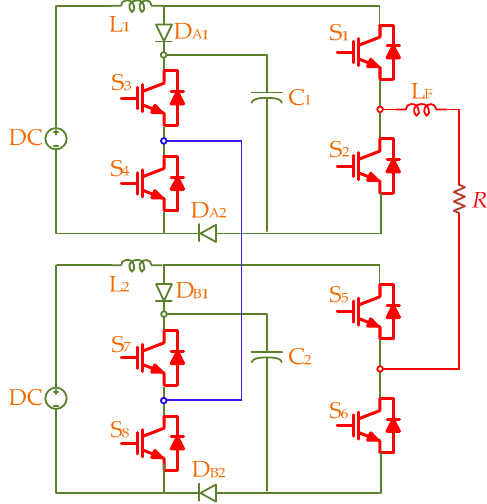
Figure 25. Quasi-cascaded H-bridge five-level boost inverter.